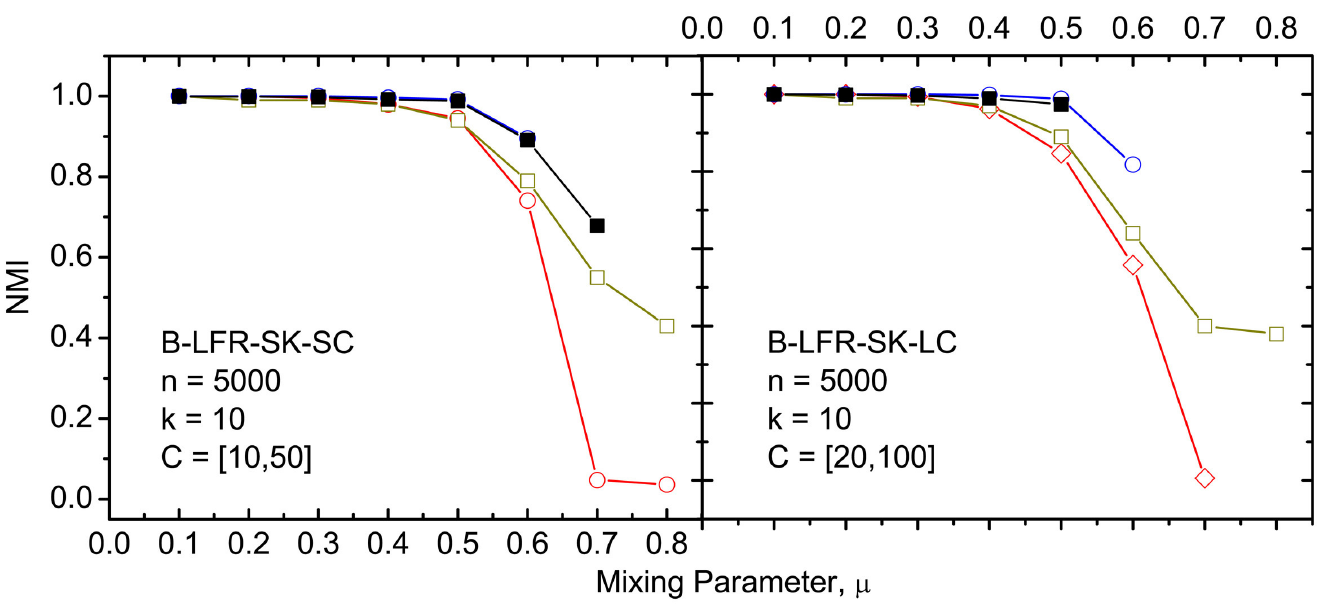
Fig 6. The NMI comparison on undirected and unweighted big LFR benchmark networks with small average degree. The legend is the same as in Fig 4.